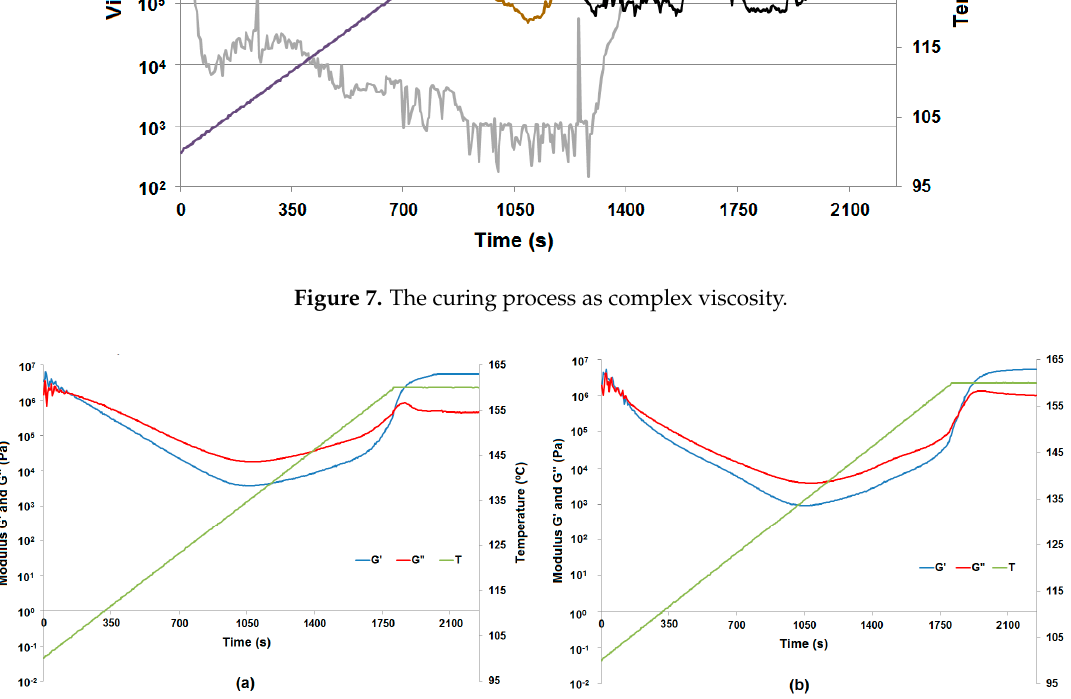
Figure 8. Phase transformation of lignin-Al 2 O 3 (8:2, wt / wt ) represented by the moduli G ′ and G ″ ( a )